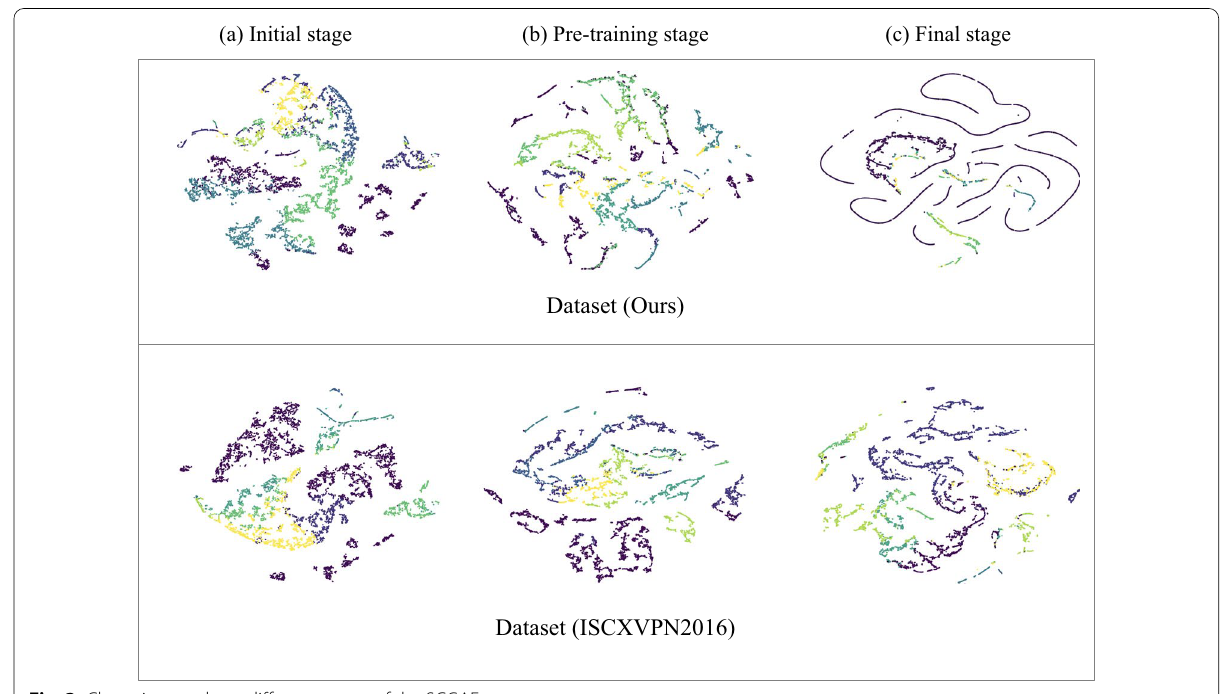
Fig. 3 Clustering results at different stages of the